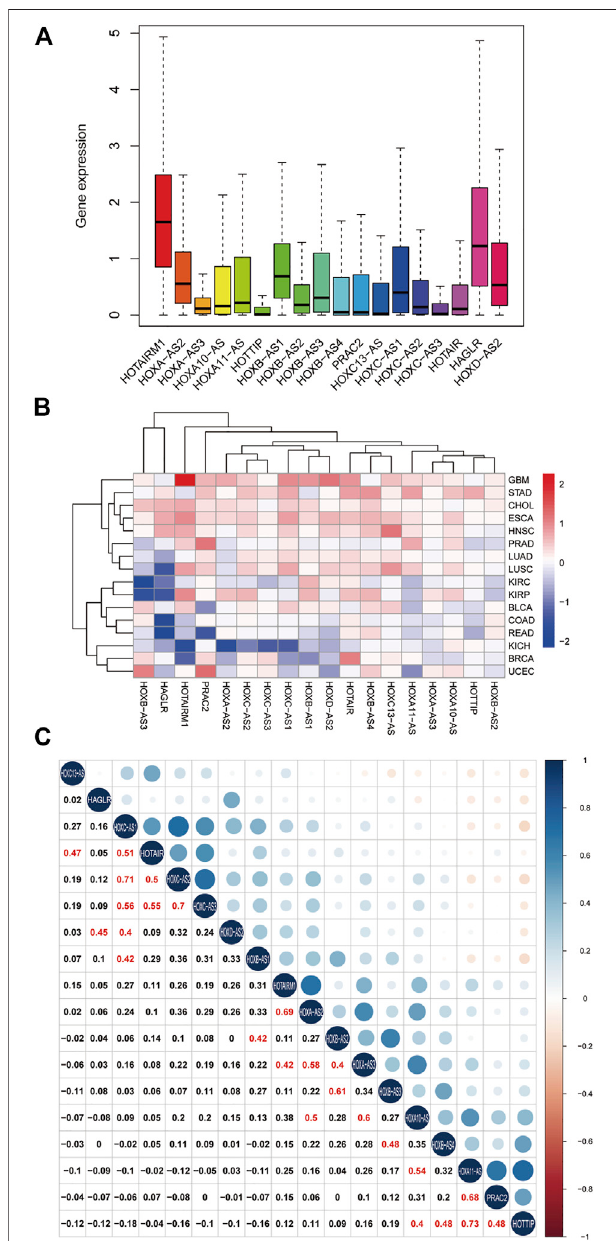
FIGURE 1 | Homeobox antisense transcripts (HOXATs) are abnormally expressed in human pan-cancer. Boxplot showing the distribution of the HOXATs expression across 33 cancer types (A) . Heatmap showing the differenceintheHOXATsexpressionbetweentheprimarytumorandthe adjacent normal tissues, which was based on log2 (fold change) of 16 cancer types that had more than fi ve adjacent normal samples (B) . Correlation plot based on Spearman ’ s correlation test showing the correlation of gene expression among the 18 HOX-related long non-coding RNAs (lncRNAs) across the 33 cancer types (C)